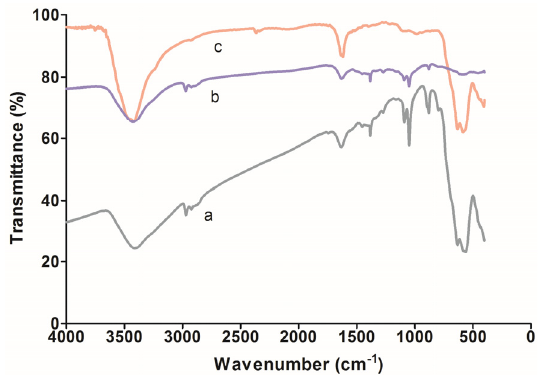
Figure 3. FT-IR (fourier transform infrared spectroscopy) spectra of ( a ) P p PD/Fe 3 O 4 nanocomposites, ( b ) P p PD and ( c ) Fe 3 O 4 .